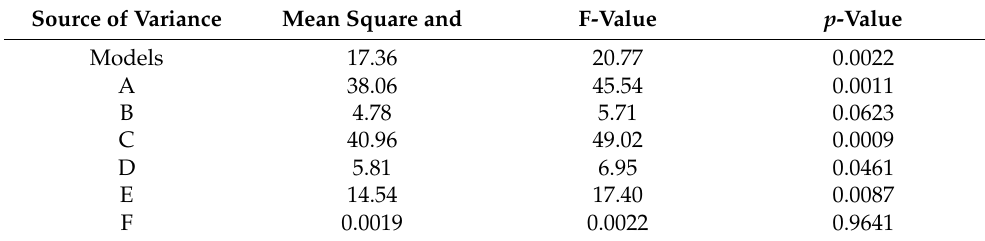
Table 4. ANOVA of Plackett-Burman test results. Source of Variance Mean Square